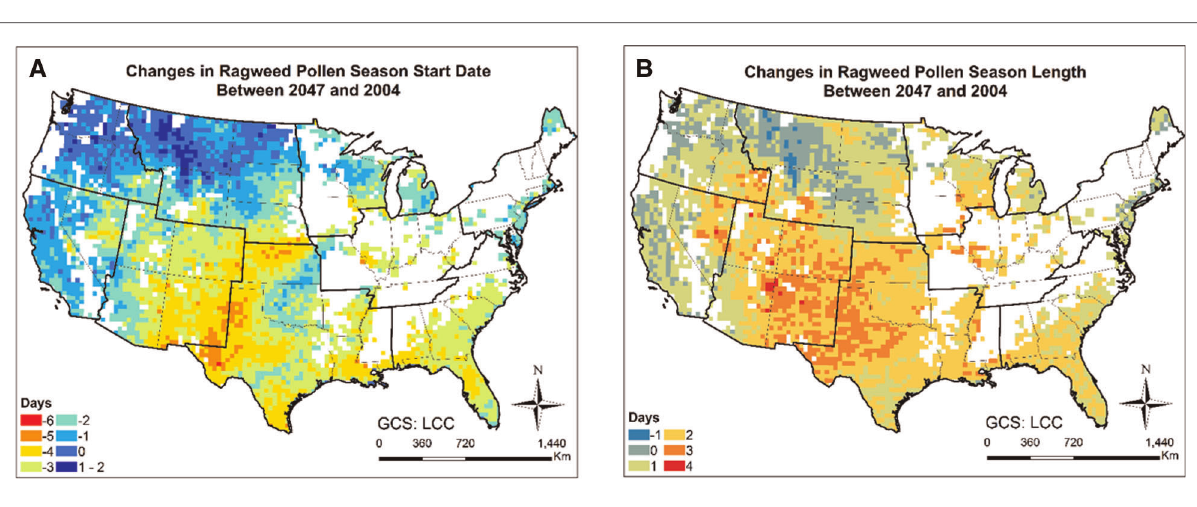
FIGURE 10 Changes in ragweed pollen season between 2047 and 2004 estimated for the RCP8.5 climate change scenario using the CMAQ-Pollen model. ( A ) Changes in ragweed pollen season start date between 2047 and 2004; ( B ) Changes in ragweed pollen season length between 2047 and 2004. Data were mapped only on cells in which the area coverage of ragweed is greater than